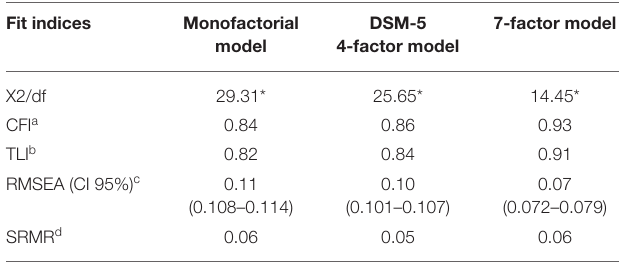
TABLE 1 | Confirmatory factor analyses results for Monofactorial Model, DSM-5 4-factors model and 7-factors model. Fit indices